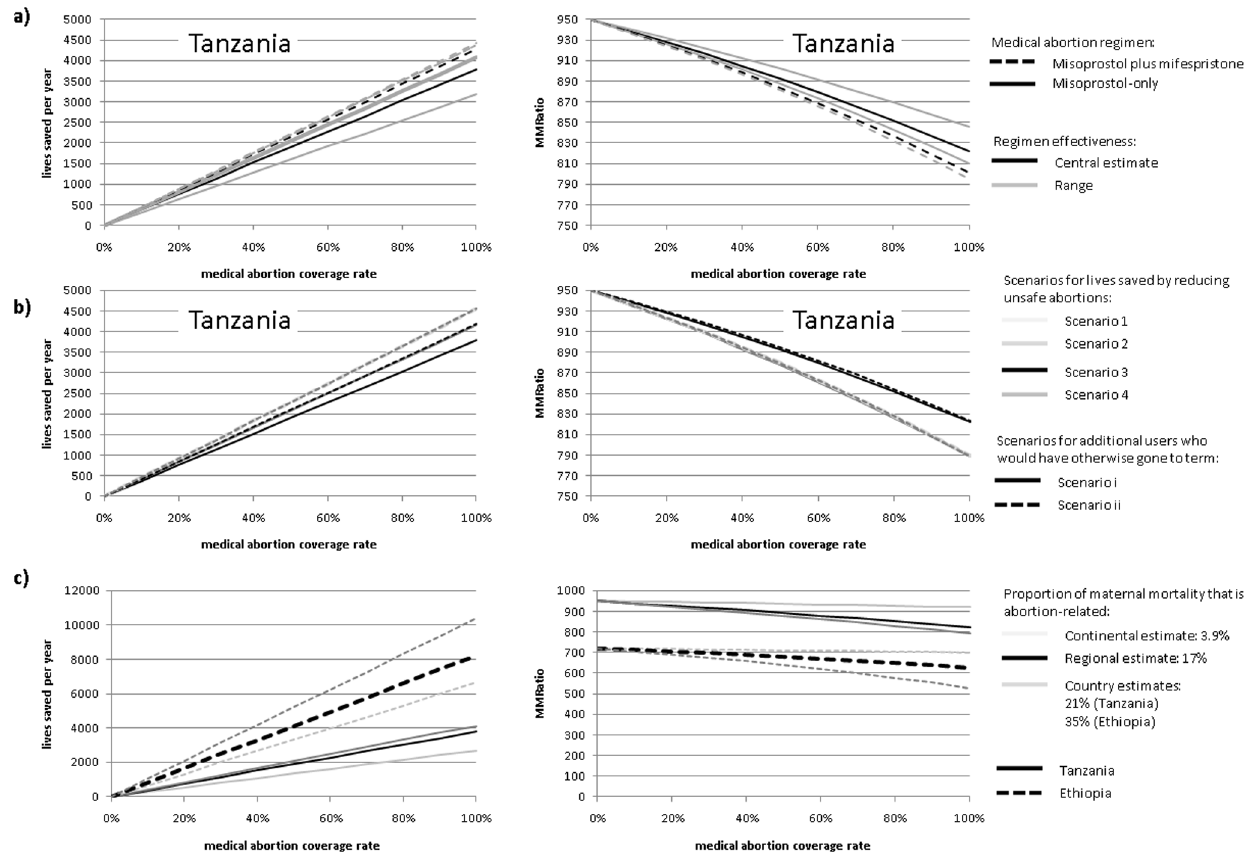
Figure 4. Sensitivity of model output (lives saved per year and MMRatio by medical abortion coverage rate) to different model assumptions and parameter values. a) Effectiveness of medical abortion regimen, for Tanzania: comparing misoprostol-only (estimated effectiveness 85% range 73–92% first trimester, 80% range 65–85% second trimester) with misoprostol plus mifepristone (estimated effectiveness 96% range 94–97%, both trimesters). b) Scenarios for those women who experience an unsuccessful medical abortion (see Figure 2 and Methods for descriptions of each scenario). c) Proportion of maternal mortality that is abortion-related, comparing national, regional and continental estimates. Results are for impact of medical abortion in terms of reduced unsafe abortions plus additional potential users. MMRatio graphs use central